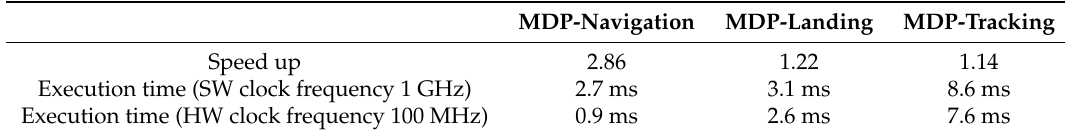
Table 9. MDP speed up and SW/HW execution time.